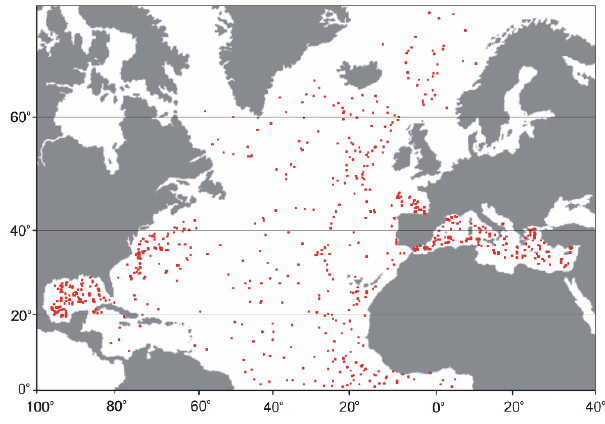
Figure 3. Location of the core-tops composing the PaleoUma calibration database.